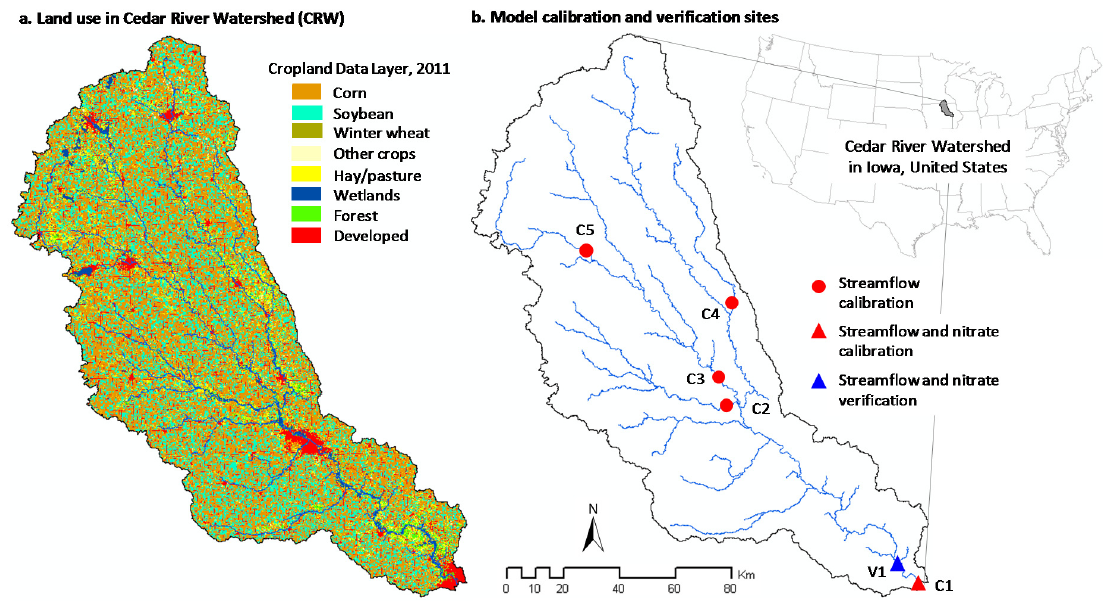
Figure 1. The 16,860-km 2 Cedar River Watershed (CRW) in Iowa, United States. ( a ) Land use map showing the agriculture-dominated landscape in the CRW, and ( b ) U.S. Geological Survey (USGS) gage stations across the watershed used for model calibration and verification. The corresponding station IDs are as follows: C1 = 05464500, C2 = 05458900, C3 = 05462000, C4 = 05458000, C5 = 05459500, V1 = 05464420. Streamflow and nitrate data can be accessed from https://waterdata.usgs.gov/nwis using respective stations IDs.